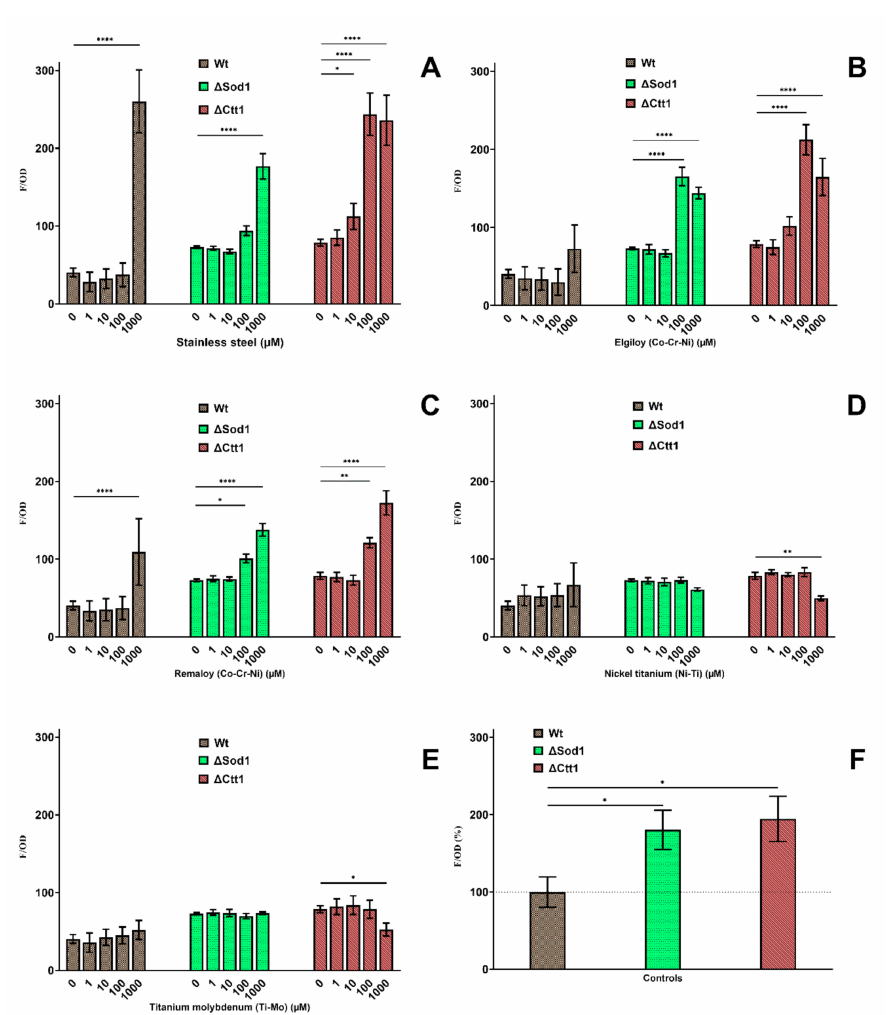
Figure 4. Influence of 24-h metal treatment on the formation of oxidative lipid damage. Wild-type, ∆ Sod1, and ∆ Ctt1 yeast strains were treated with di ff erent concentrations of stainless steel ( A ), cobalt-chromium Elgiloy ( B ) and Remaloy ( C ), nickel-titanium ( D ), and β -titanium ( E ). Graph ( F ) compares untreated control groups of di ff erent yeast strains relative to the wild type. Significant di ff erences ( p < 0.05) are indicated with * (* p < 0.05, ** p < 0.01 and **** p <